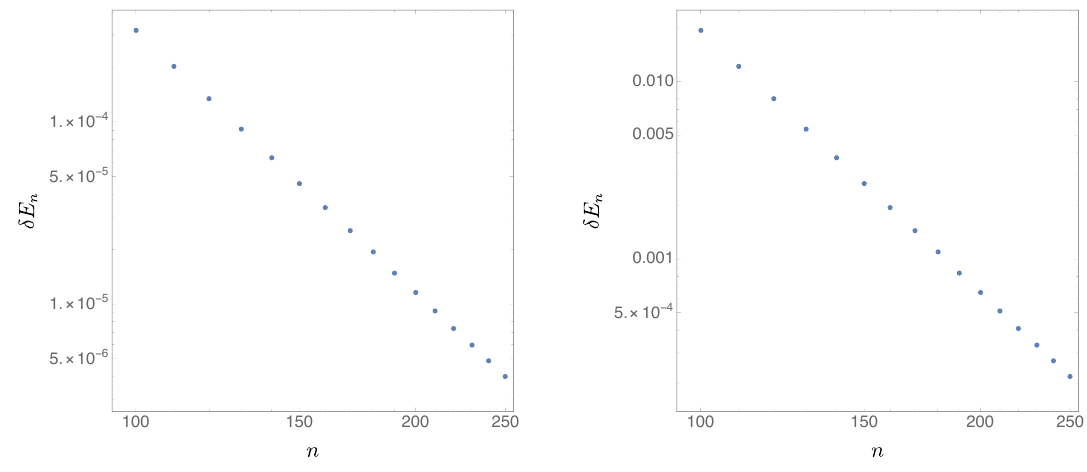
Figure 17 . (cid:14)E n as a function of n for the droplet (left panel) and funnel (right panel) phases. In p both cases we used (cid:26) = 0 :